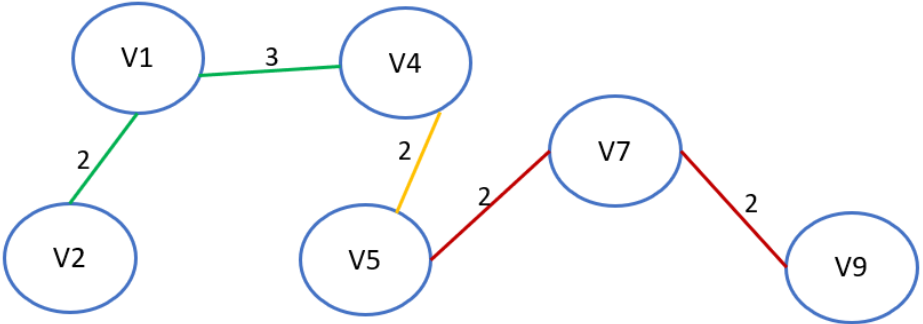
Figure 7. Optimal route in a multilayer data transmission network .